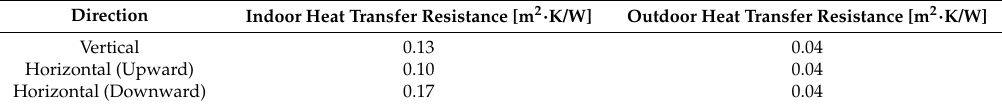
Table 2. Values for Heat transfer resistance according to ISO 6946.